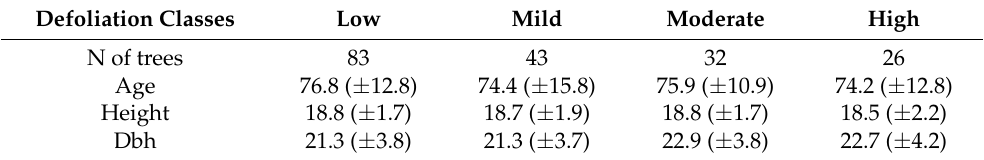
Table 1. Number of trees and mean ( ± standard deviation) tree age, mean height in metres, and mean diameter-at-breast-height (dbh) in cm by defoliation class (low 0%–10%, mild 20%–30%, moderate 40%–60%, and high 70%–100%) in 2010. The age of each tree was measured from the sample core. Defoliation Classes Low Mild Moderate